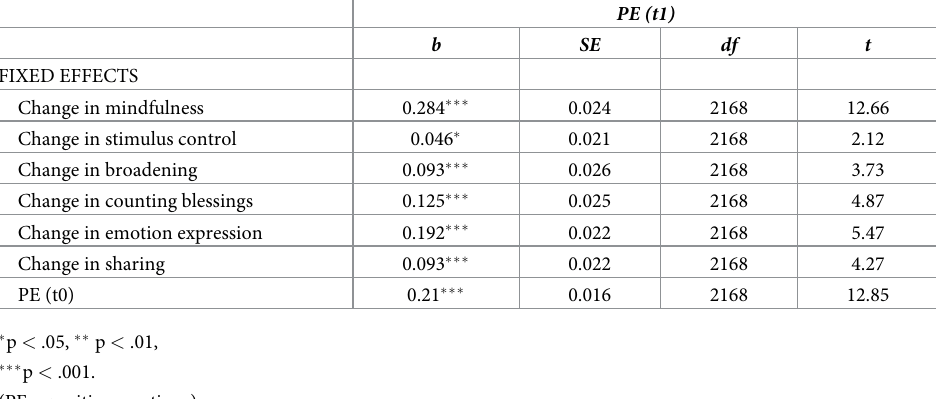
Table 3. Results of the linear mixed-effect model predicting PE at t1 from change in the use of each strategy at t0. PE (t1) b SE df